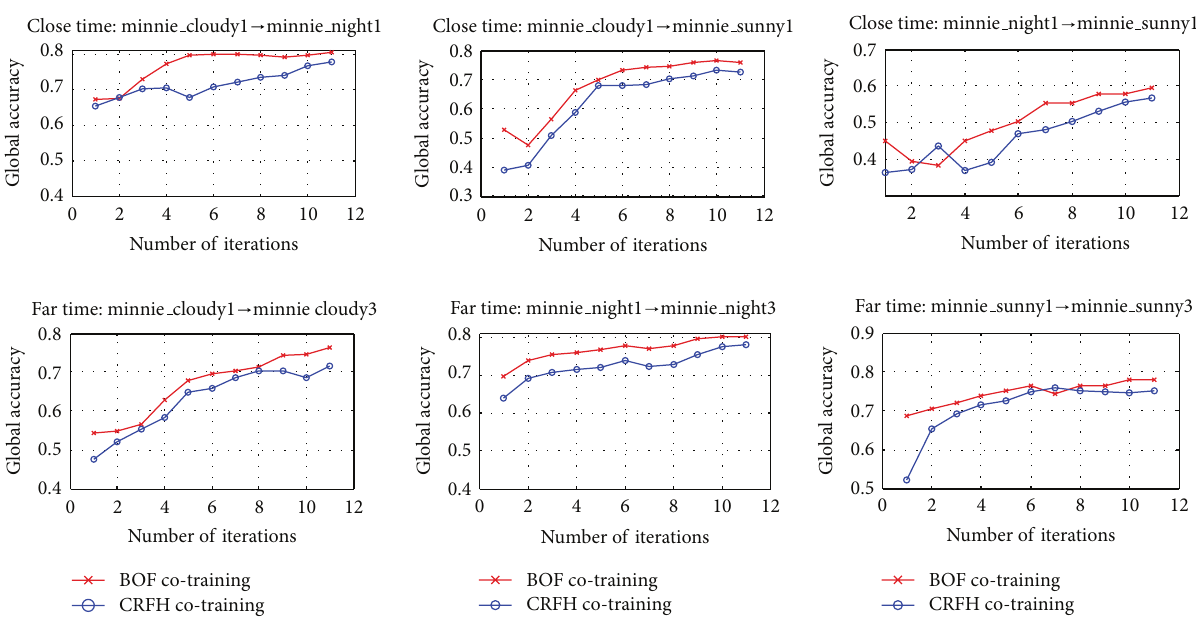
Figure 10: Evolution of the accuracy of individual inner classifiers of the Co-Training module as a function of the number of feedback loop iterations. (IDOL2 dataset, video-versus-video setup). The plots are shown for six sequence pairs: (top) same lighting conditions, (bottom) different lighting